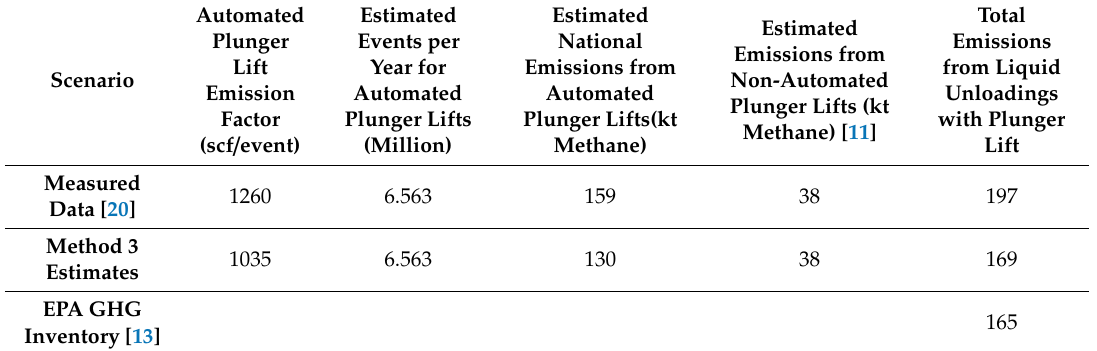
Table 2. Comparison of estimated methane emissions (kt methane) in 2012 for liquid unloading events with plunger-lift assist.